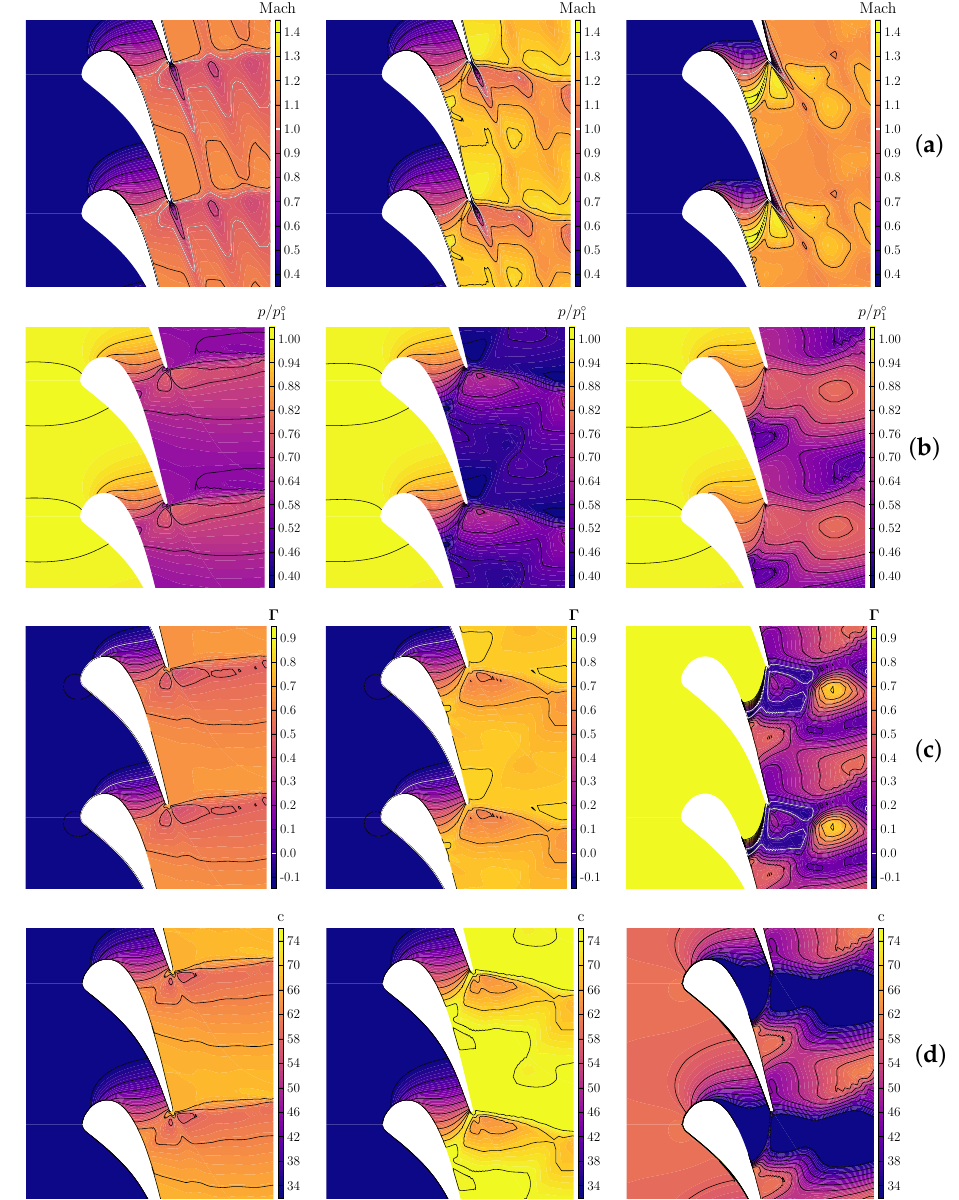
Figure 4. Isocontours of averaged quantities: Mach number (row ( a )), pressure p / p ◦ fundamental derivative Γ (row ( c )), and speed of sound (row ( d )) for the cases IC1-LPR ( left ), IC1-HPR ( middle ), and IC2-LPR ( right